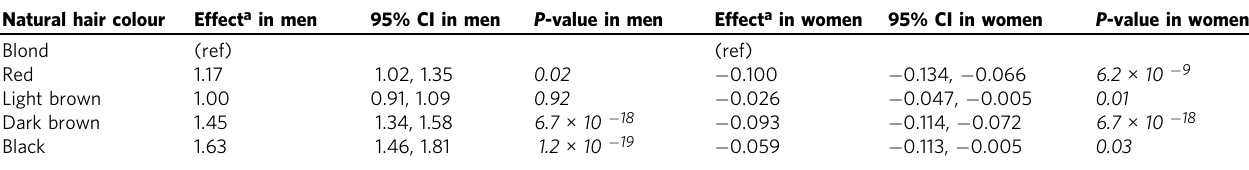
Table 2 Phenotypic associations between natural hair colour and puberty timing in UK Biobank men and women. Natural hair colour Effect a in